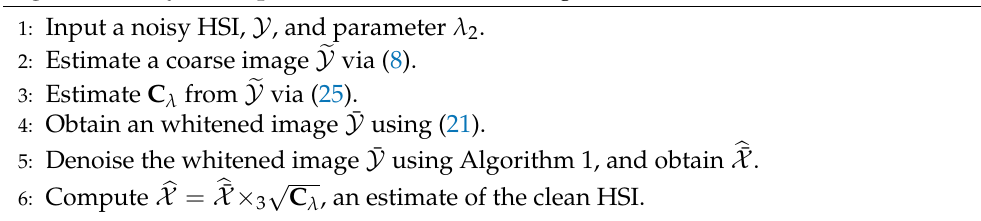
Algorithm 2 HySuDeep for mixed noise containing non-i.i.d. Gaussian